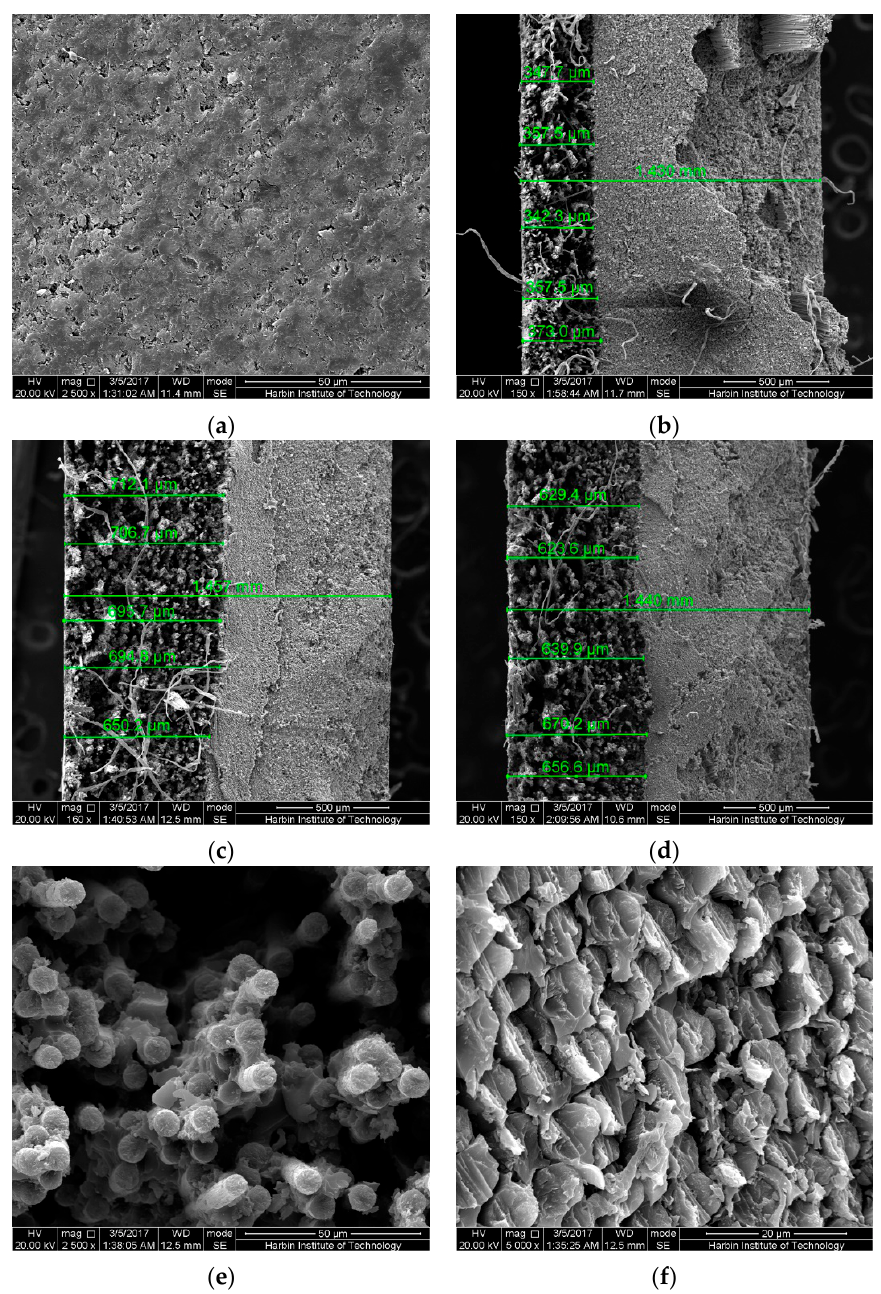
Figure 17. The cross-section in the mid-span region of the broken epoxy-based CFRP samples under 58% of strain level for 6 months: ( a ) controlled samples, ( b ) seawater at 20 ◦ C, ( c ) seawater at 60 ◦ C, ( d ) water at 60 ◦ C, ( e ) tension area in water at 60 ◦ C, ( f ) compression area in water at 60 ◦